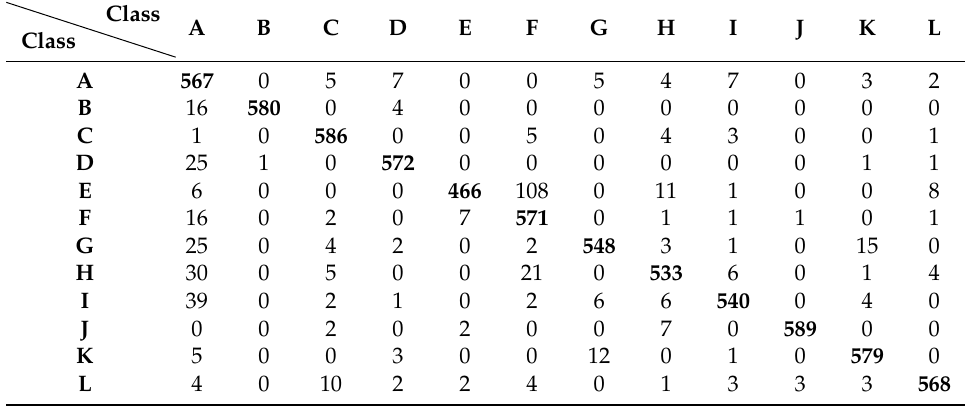
Table 5. Classification results after combination using Borda count procedure without